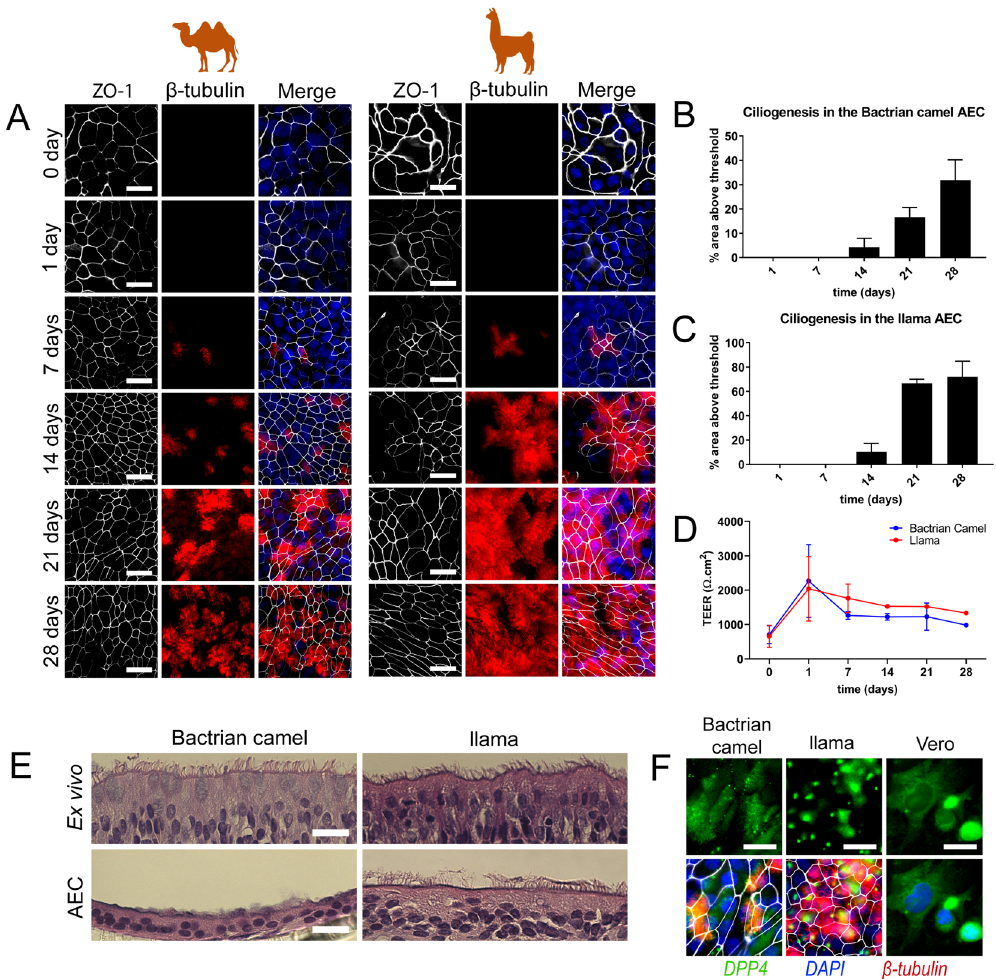
Figure 1. Establishment and characterization of Bactrian camel and llama AEC cultures. ( A ) Immunofluorescence analysis showing the development of tight-junctions (ZO-1, white) and ciliogenesis (β-tubulin, red) in Bactrian camel and llama AEC cultures over time from 1-day to 4 weeks post ALI exposure. The cells were counterstained with DAPI (blue) to visualize the nuclei. ( B,C ) Ciliogenesis quantification of camel and llama AEC cultures overtime, respectively. Ciliation was quantified by measuring the area above a fluorescence intensity threshold of five random images acquired per condition. ( D ) Transepithelial electrical resistance (TEER) measurement of camel and llama AEC cultures overtime during the differentiation. ( E ) Epithelial morphology of ex vivo tissues (upper panel) and well-differentiated camel and llama AEC cultures (lower panel). ( F ) DPP4 expression in well-differentiated camel and llama AEC cultures, with Vero cells as a positive control. Scale bar is 20